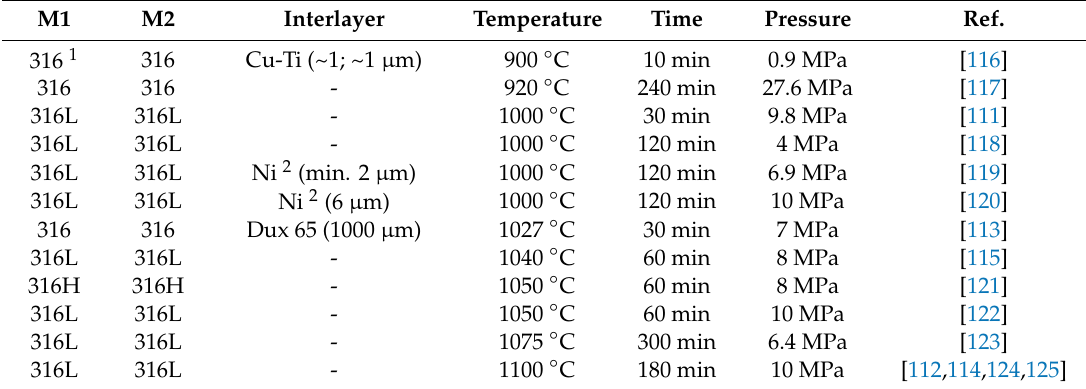
1 Metal foam, 2 Ni nanoparticles.